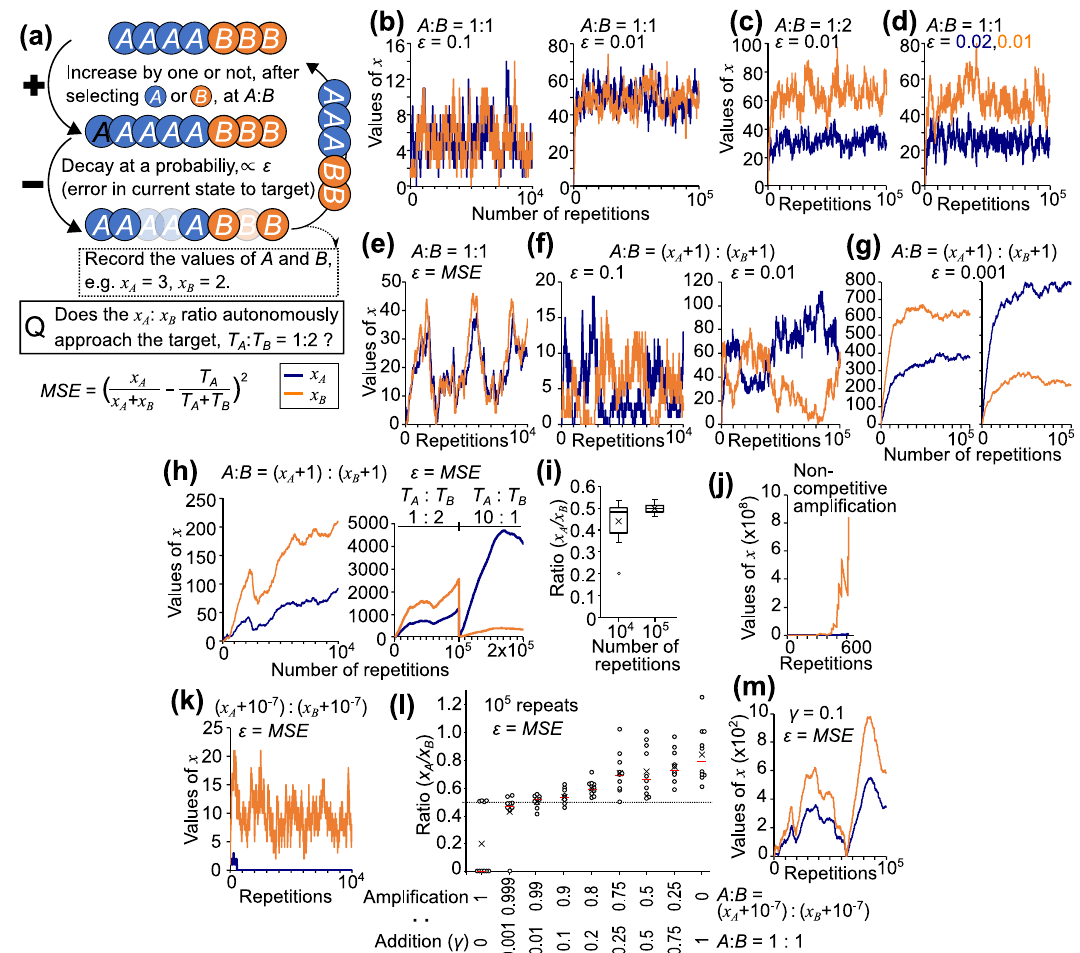
Figure 1. Regulation of two factors through stochastic processes of increase and decrease. ( a ) Scheme of the simulation to reveal minimum processes required for learning. The non-negative integer values of factors A and B , x A and x B , change by repeating stochastic processes of increase and decrease. For every 10 repeats on average, A or B is selected at an A : B ratio, increasing the selected x A or x B by one unit. Each unit in x A and x B disappears at a probability of 0.1 ε , due to the decay every repeat. See text for concrete examples, Table 1 for the definition of parameters, and Fig. 6 for the mathematical formula. ( b – m ) The number of repetitions of these processes are indicated on the x-axis ( b – k , m ). The values of x A (blue) and x B (orange) ( b – h , j , k , m ) and the x A / x B ratio ( i , l ) are shown. ( b ) Additive increase at a 1:1 ratio and decay with a constant probability. ( c ) Additive increase at a 1:2 ratio and decay with a constant probability. ( d ) Additive increase at a 1:1 ratio, and x A and x B decay with constant probabilities of 0.002 and 0.001, respectively. ( e ) Additive increase at a 1:1 ratio and decay with probability equal to the MSE between the current ( x A : x B ) and target (1:2) ratios. ( f , g ) Competitive amplification with a bias term (increase by one, selecting A or B at a ( x A + 1):( x B + 1) ratio), and decay with a constant probability. ( h , i ) Competitive amplification and MSE -dependent decay. Target ratio T A : T B is changed from 1:2 to 10:1 after 10 5 repeats. ( i ) Ratios of x A to x B in 10 tests are shown in box and whisker plots indicating the interquartile range, 1.5 × the interquartile range, the mean (cross), and the data in outlier region (circle). ( j ) Non- competitive amplification and MSE -dependent decay. ( k ) Competitive amplification without additive increase setting bias β = 10 −7 , and MSE -dependent decay. ( l , m ) Competitive amplification without bias ( A : B = ( x A + 10 −7 ): ( x B + 10 −7 )) or additive increase ( A : B = 1:1) is selected at a (1 − γ ): γ ratio in an increase process. The x A / x B ratio at 10 5 repeats in 10 tests are shown in circles with the mean (cross) and median (red bar) in ( m ). The target ratio 0.5 is indicated by a dotted